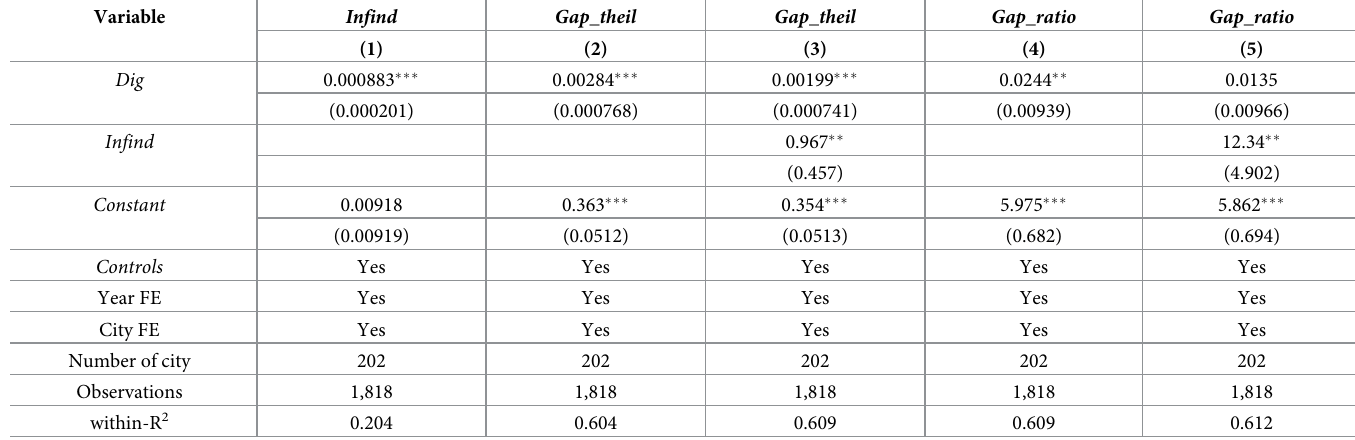
Table 3. Mechanism test: Mediating variable is Infind